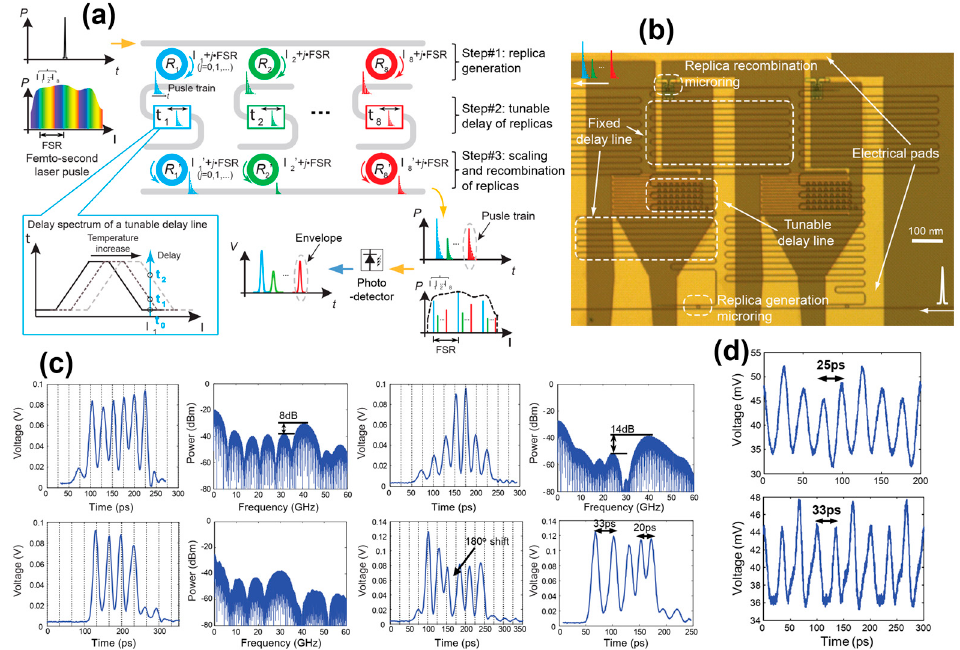
Figure 24. Pulse shaper consisting of 8 MRRs reported in [135]: ( a ) Operation principle of the proposed pulse shaper; ( b ) An optical image of a fabricated on-chip pulse shaper; ( c ) Demonstrated RF bursts and their spectra; ( d ) Single-tone continuous RF waveforms. Courtesy of and adapted from Minghao Qi and Andrew M. Weiner [135].